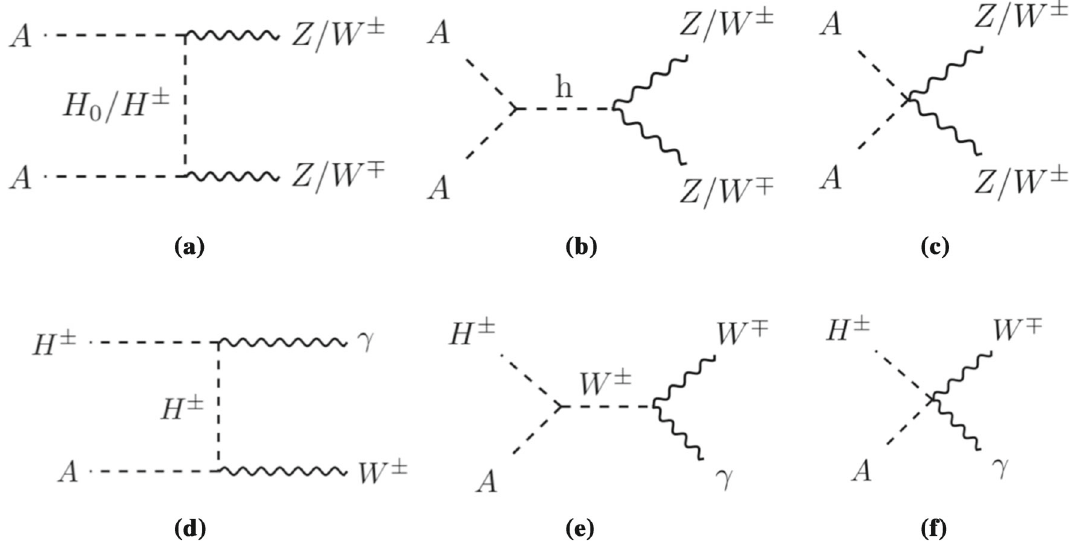
Fig. 8 Dominant annihilation and co-annihilation modes that contribute to DM relic for IDM